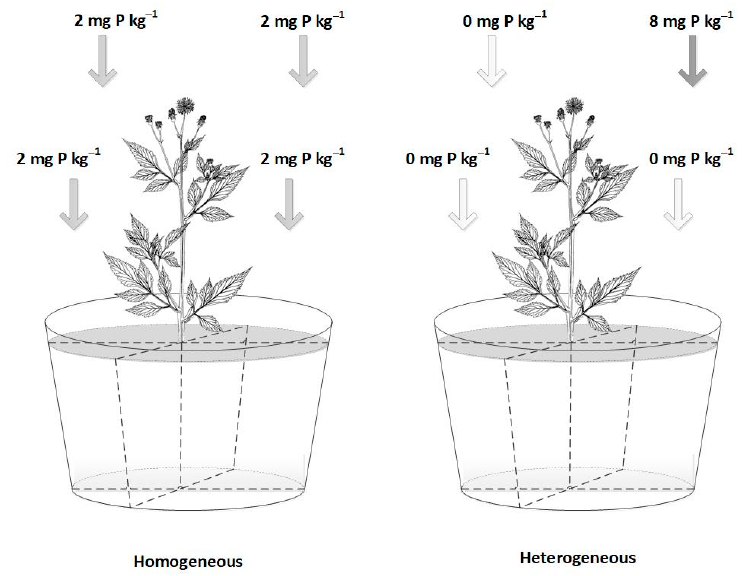
Figure 1. Experiment layout of homogeneous and heterogeneous phosphorus (P) patterns in pots where sands are divided into four quarter-sections. In the homogeneous P pattern, all four pot quarters received low P inputs at a rate of 2 mg kg − 1 . In the heterogeneous P pattern, one random quarter received high P input at the rate of 8 mg kg − 1 and the rest received no P supply.